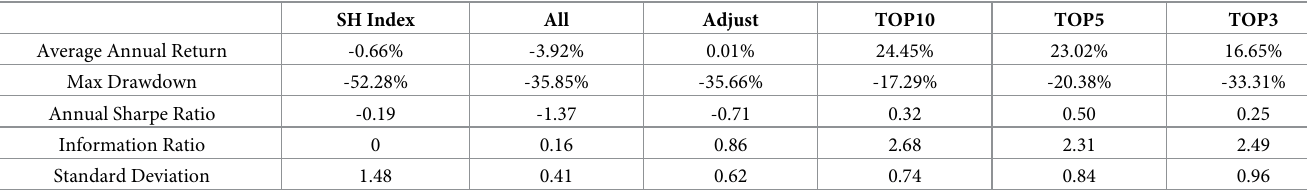
Table 8. Finance performance of two-day predictions one day ahead with 0.2% transaction